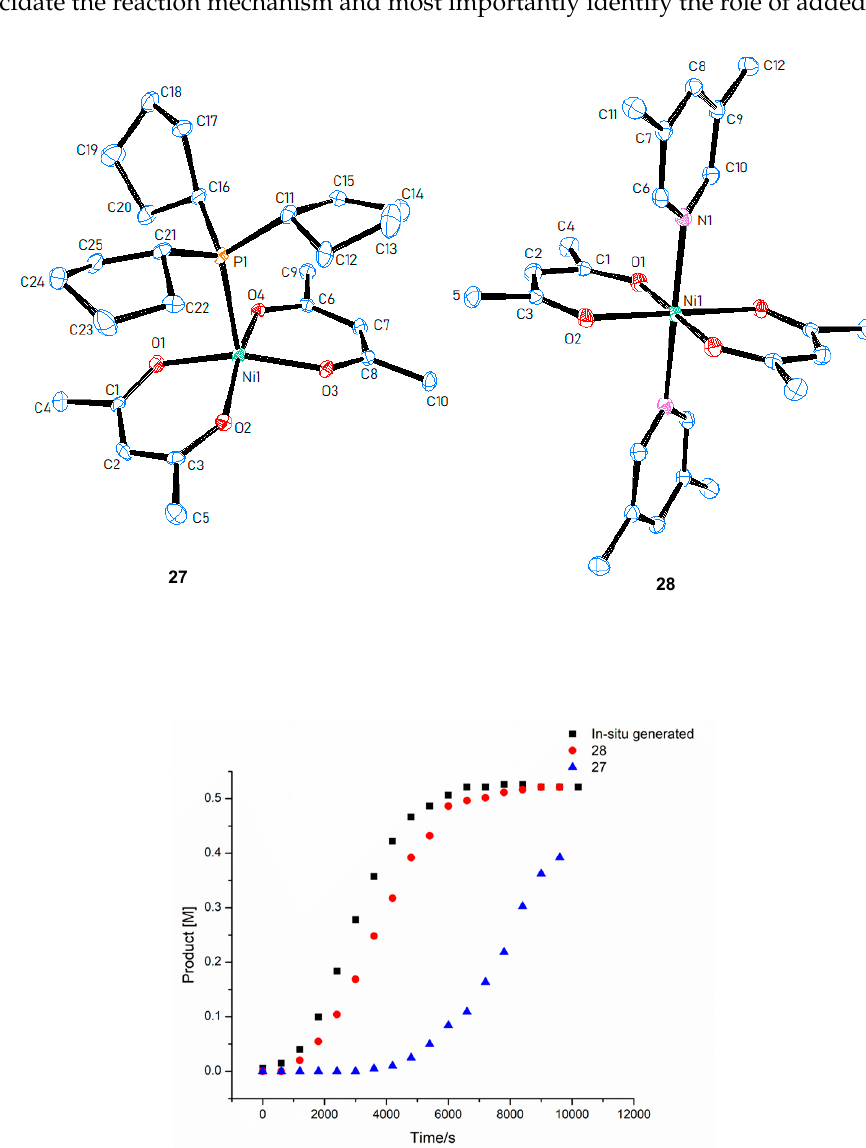
Figure 2. Top (left) solid-state structure of Ni(acac) 2 / PCyp 3 ( 27 ) complex; (right) solid-state structure of Ni(acac) 2 / lutidine complex ( 28 ); (Bottom) Kinetic profile of the reduction of lutidine in the presence of an in-situ generated catalyst, 27 and 28 [51].